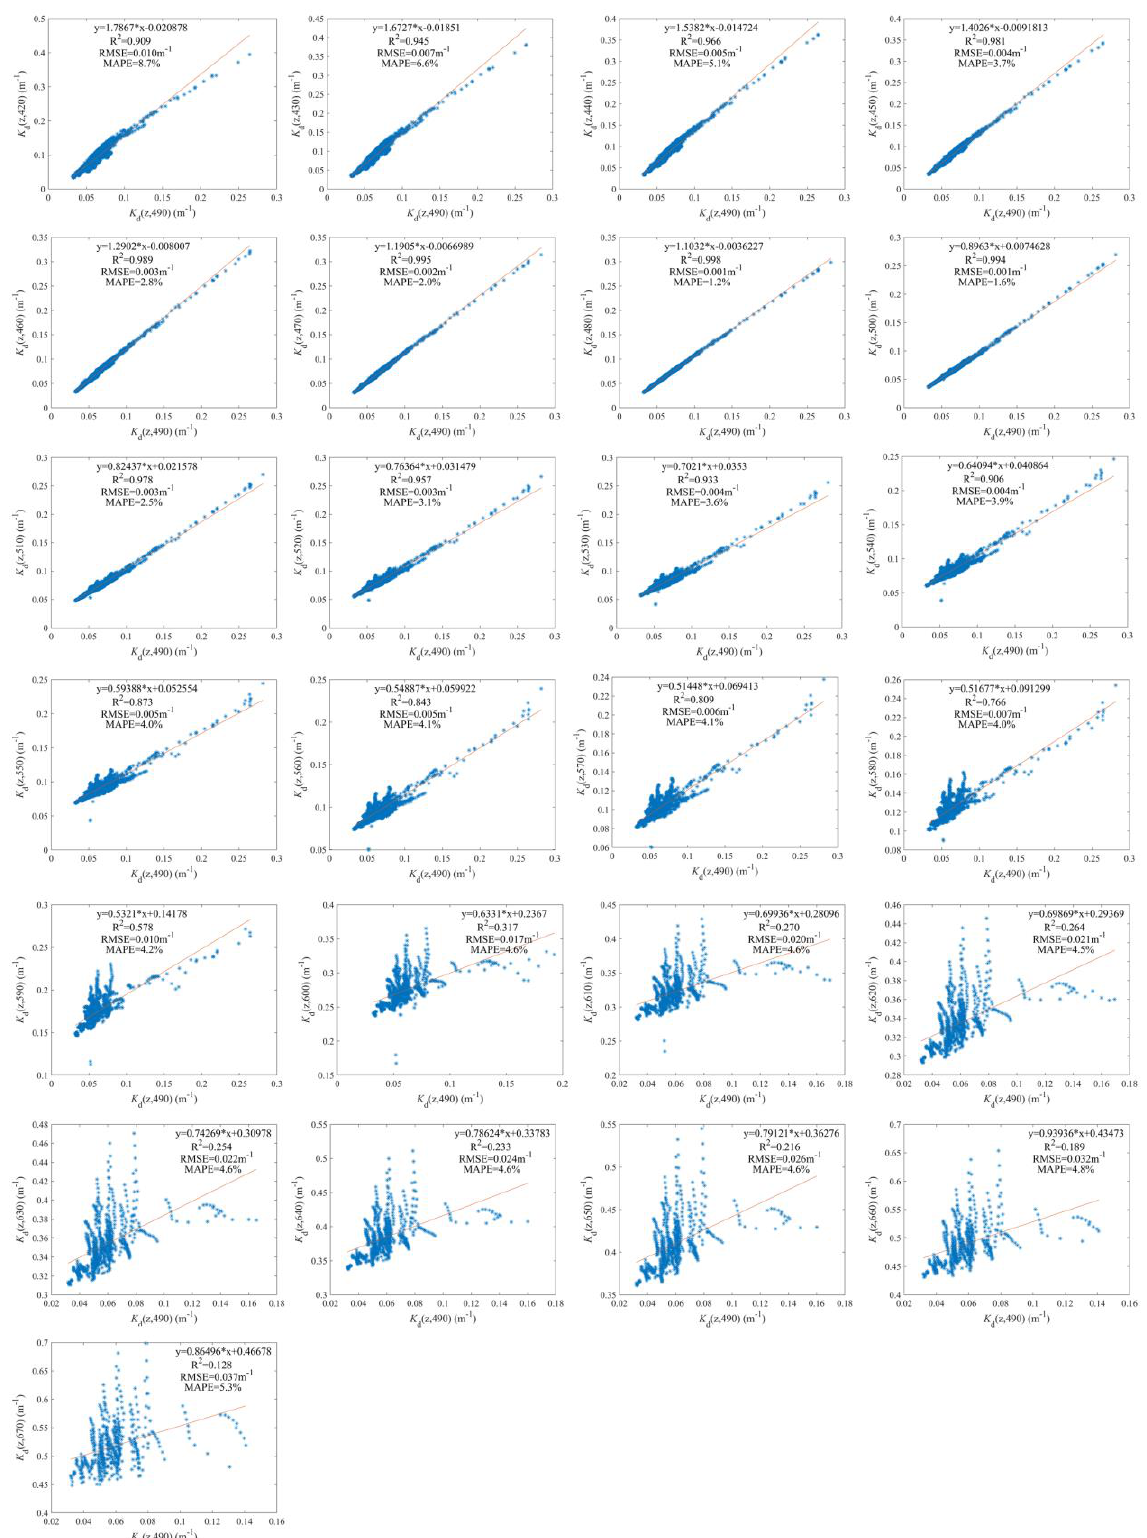
Figure 8. Linear relationships between K d ( z , λ ) (420~670 nm) and K d ( z ,490 )